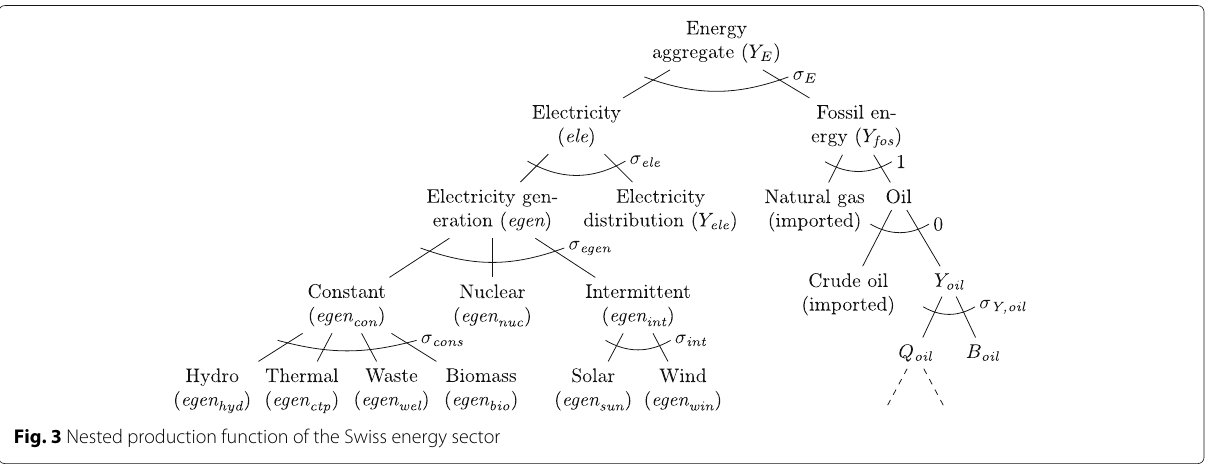
Fig. 3 Nested production function of the Swiss energy sector